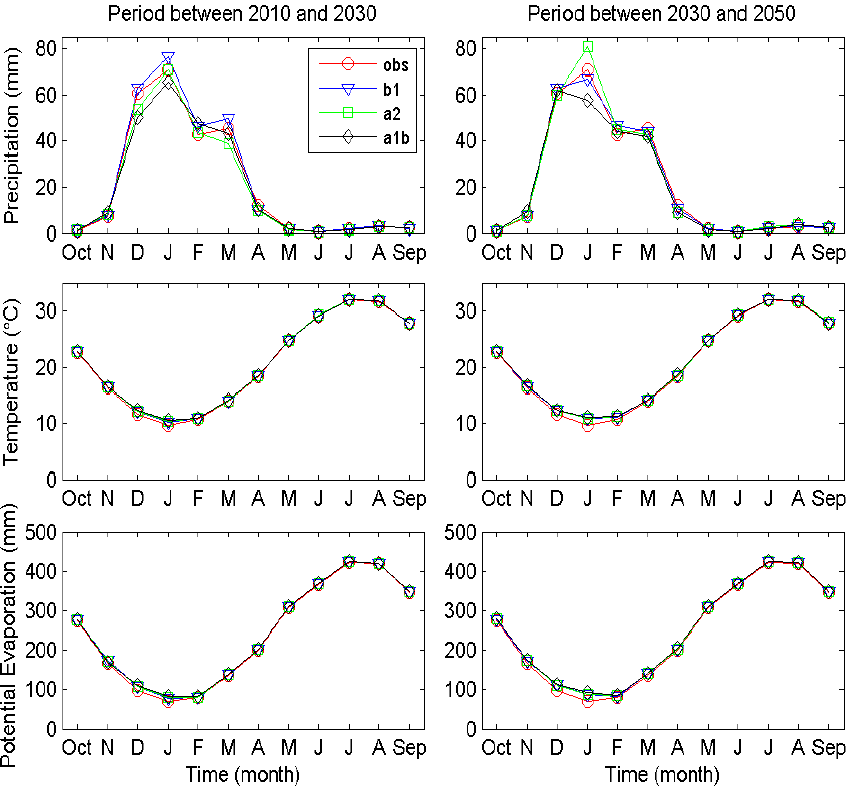
Figure 6. Mean monthly precipitation (mm), temperature ( ◦ C), and potential evaporation (mm) for historical climate data (1990–2010) relative to A1b, A2, and B1 scenarios for the periods 2010–2030 and